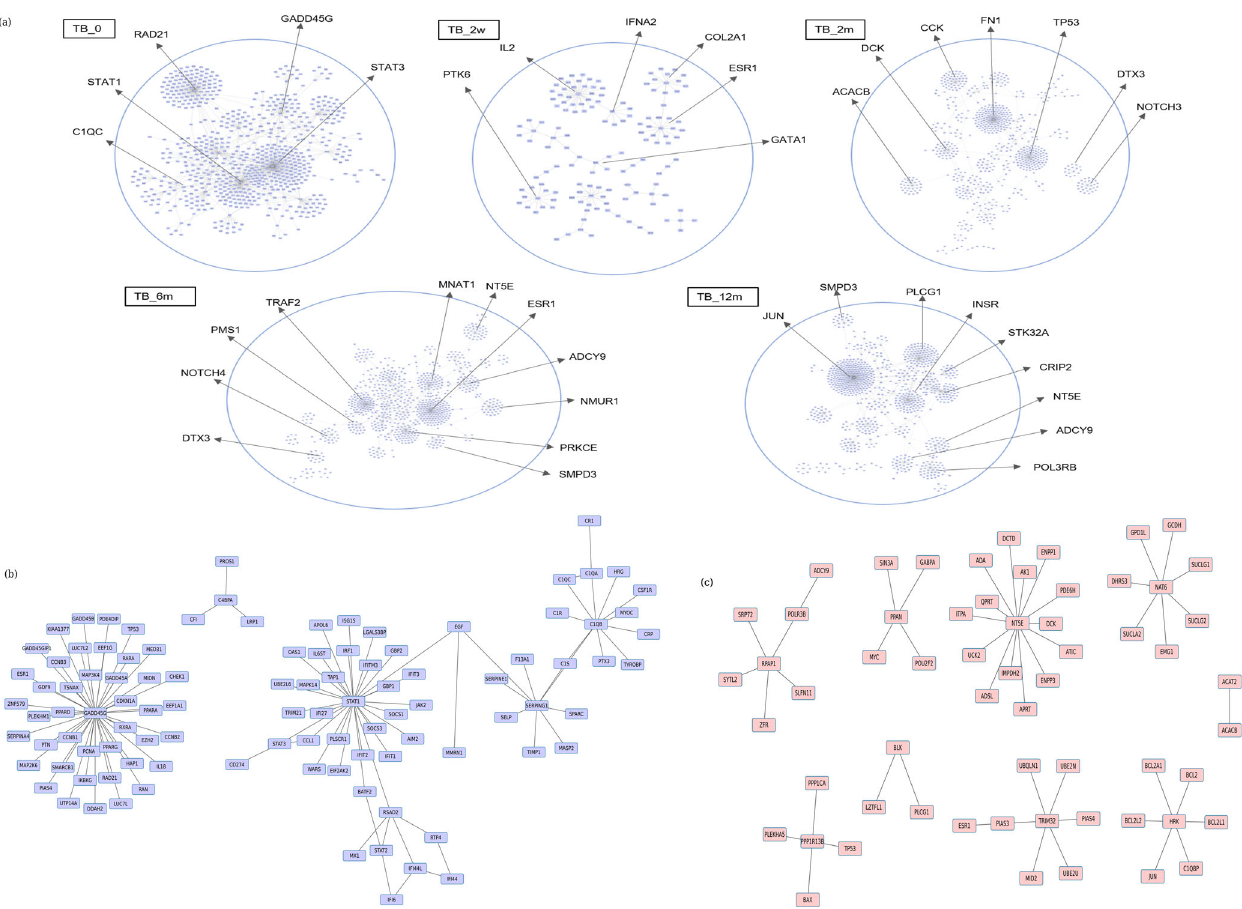
Fig. 6 Monitoring the common core upon treatment. a Variation in network topology observed in individual response networks at time points of diagnosis, 2 weeks, 2 months, 6 months and 12 months post anti-tubercular therapy. The hub nodes occurring at different time points are highlighted b Subnetwork of the common core lost gradually over 6 months of treatment c Subnetwork emerging post 6 months of treatment indicating possible end points of